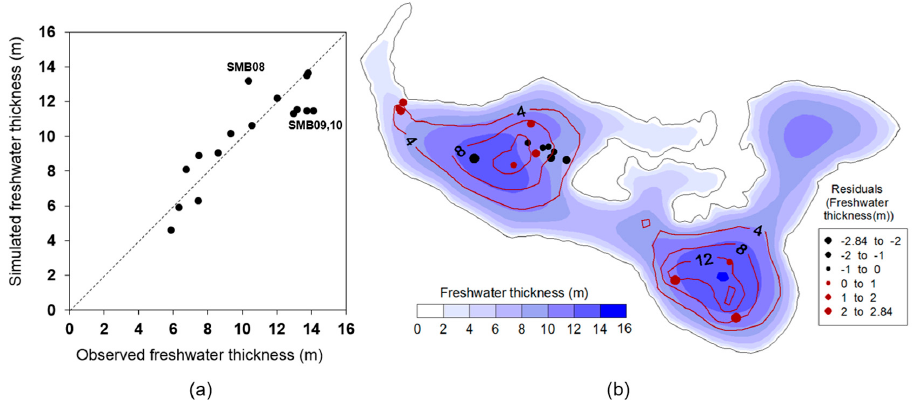
Figure 3. Steady-state calibration results; ( a ) simulated-versus-observed freshwater thickness at SMBs and ( b ) contours of simulated (blue) and observed (red) freshwater thickness; observed freshwater thickness contours are based on freshwater thickness shown in Figure 3a.